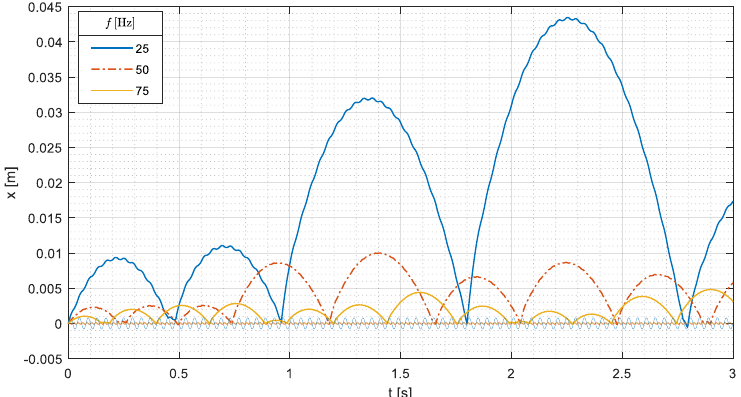
Figure 11. Numerical results, displacement of the cylindrical part along the track, 𝜃 = 3° , 𝜓 = 0°, 𝑓 𝑣 = 0.005 , 𝜇 𝑐 = 0.3, 𝜇 𝑠 = 0.6 , and parametric values of frequency.